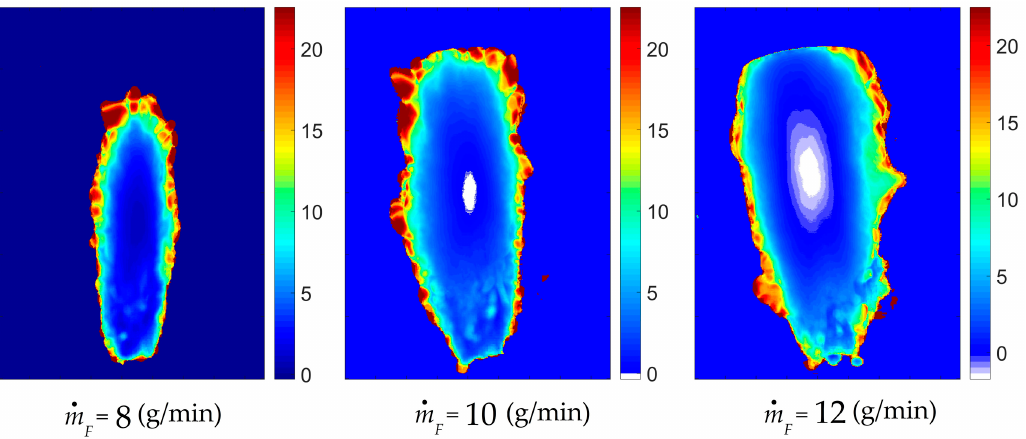
Figure 7. The distribution of skewness for the mass flow rate of fuel.